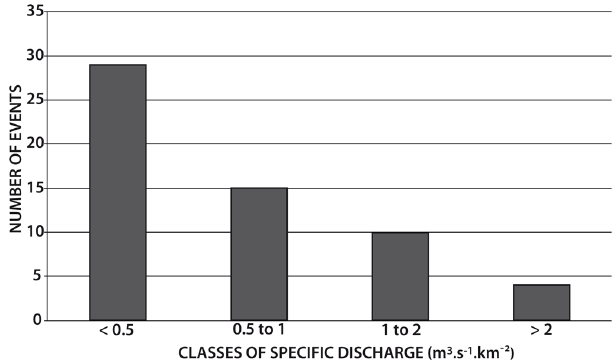
Fig. 4. Distribution of specific discharges in events extracted from the database vs. class.